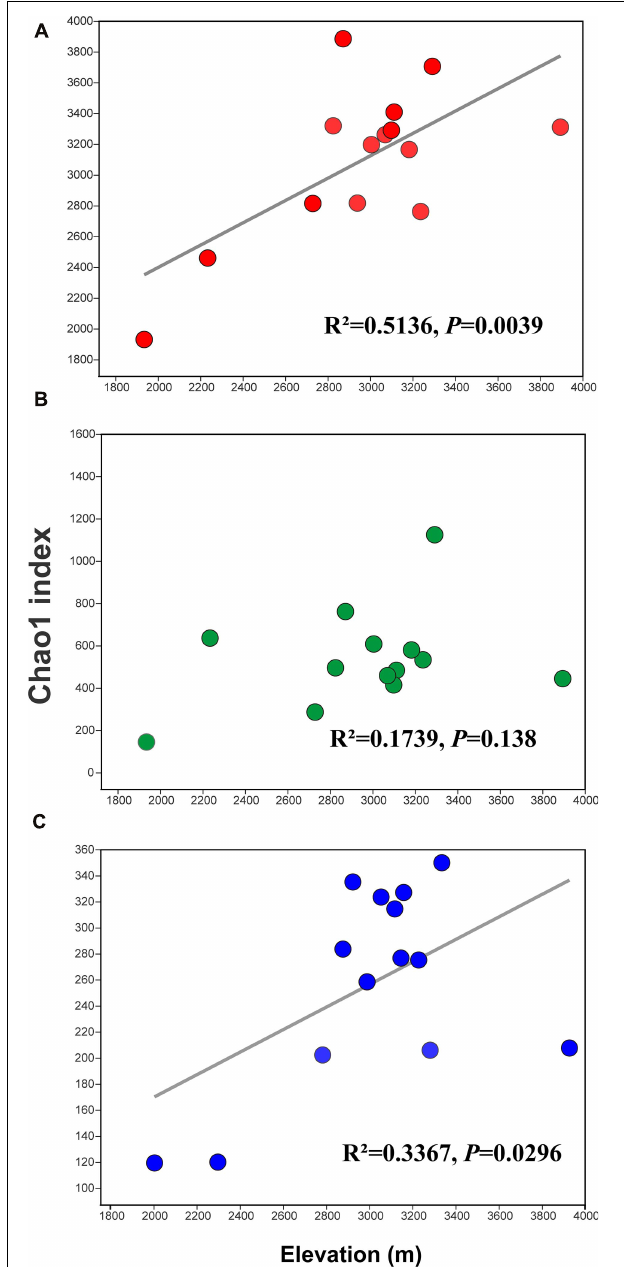
FIGURE 2 | Linear regression analysis for the relationships between the Chao1 index and elevation. Values are for (A) the bacterial samples, (B) the archaeal samples, and (C) the eukaryota